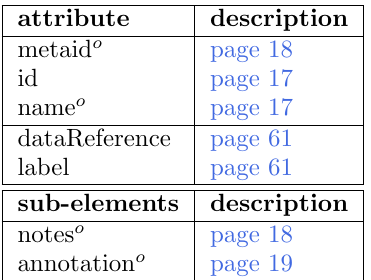
Table 2.30: Attributes and nested elements for dataSet. xy o denotes optional elements and